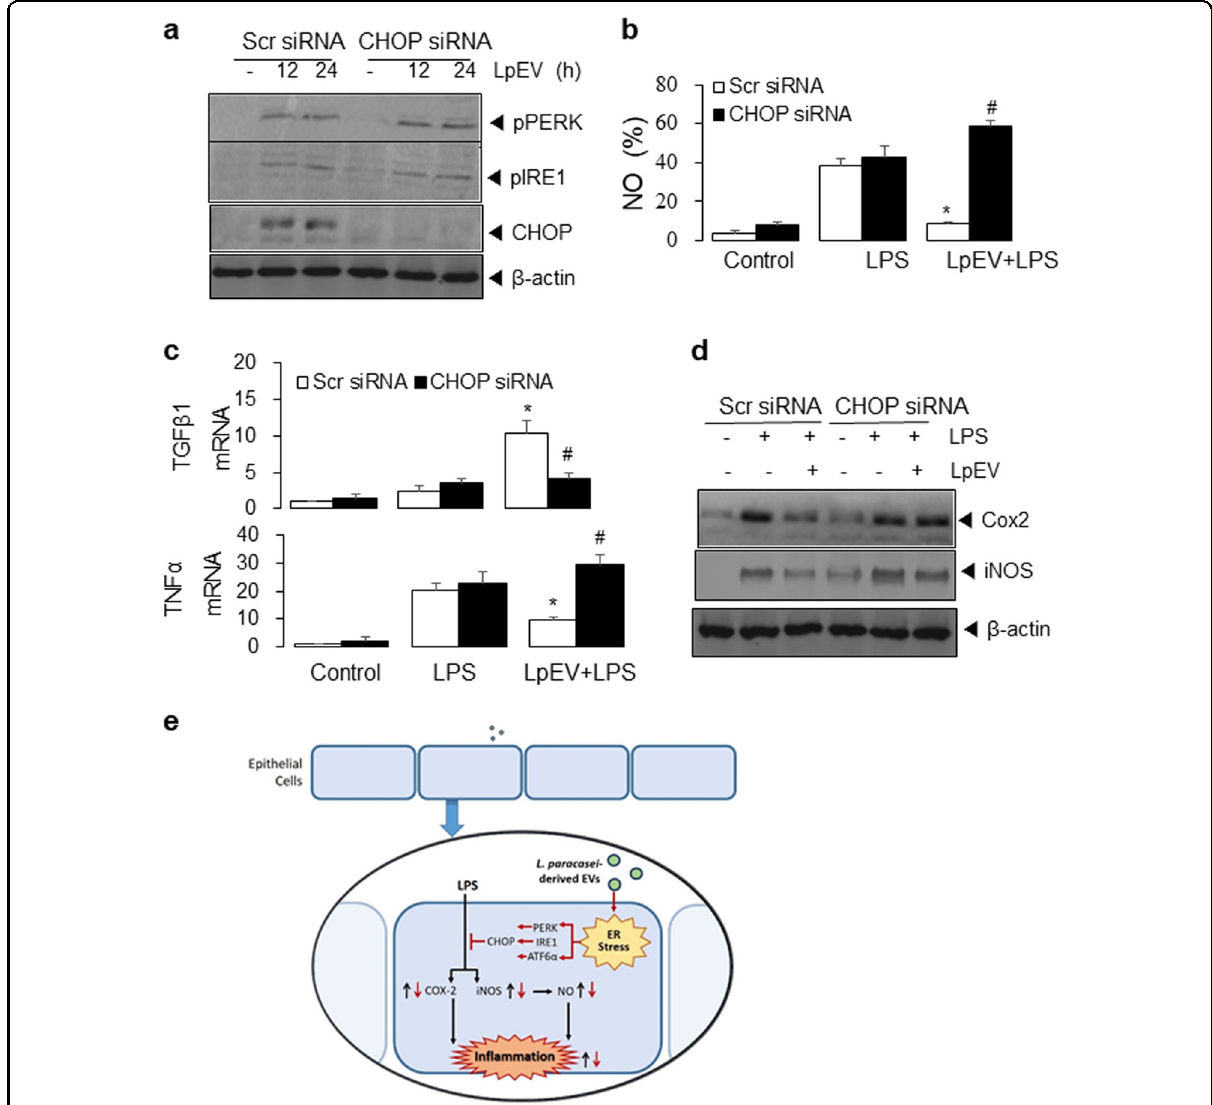
Fig. 7 Effect of LpEVs on CHOP expression in HT29 cells. a HT29 cells were transfected with scrambled (Scr) control or CHOP siRNA for 24 h and then consecutively treated with LpEVs for 12 h and LPS for 0, 12, and 24 h. NO production was determined by a 2,3-diaminonaphthalene assay. b HT29 cells were transfected with scrambled (Scr) control or CHOP siRNA for 24 h and then treated with LpEVs for 0, 12, and 24 h. Cell lysates were resolved by SDS-PAGE and analyzed by western blot analysis. c , d HT29 cells were transfected with scrambled (Scr) control or CHOP siRNA for 24 h and then consecutively treated with LpEVs for 12 h and LPS for 24 h. c The mRNA levels of TNF α and TGF β were then analyzed by qRT-PCR. d Cell lysates were analyzed by western blot analysis with antibodies against COX-2, iNOS, and β -actin. The results shown are representative of those obtained in more than three independent experiments. * P < 0.01 compared with LPS-treated cells without LpEVs. # P < 0.01 compared with LPS- treated cells with LpEVs. e The proposed model of LpEV-induced ER stress against LPS-induced in fl ammation in HT29 human colorectal cells. LPS induces COX-2, iNOS, and NF κ B activation, resulting in NO production and in fl ammatory cytokine activation. LpEVs increase the ER stress response and the activation of PERK, IRE1, and ATF6 α , leading to CHOP expression, which attenuates LPS-induced in fl ammatory